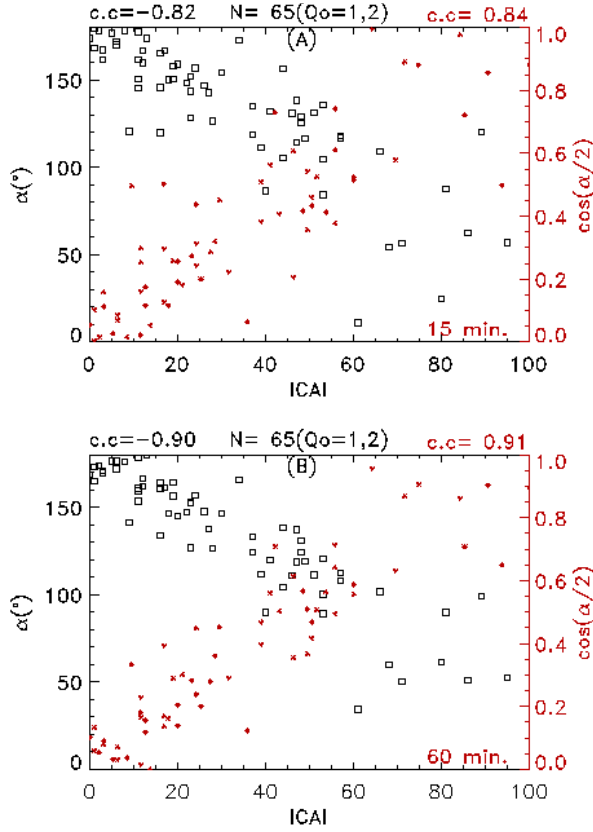
Fig. 3. The angle α (black squares) and cos( α /2) (red *) plotted against | CA | (in %) all for Q O =1,2 (where N =65), for the 15min average cases in the top panel (A) and for the 1h average cases in the bottom panel (B) Figure 3. The angle α (black squares) and cos( α /2) (red *) plotted against |CA| (in %) all for Q O = 1,2 (where N = 65), for the 15 minute average cases in the top panel (A) and for the 1 hour average cases in the bottom panel (B).